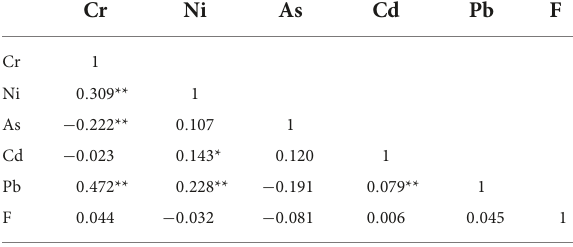
TABLE 2 Correlation analysis for PTE in wheat grains of study